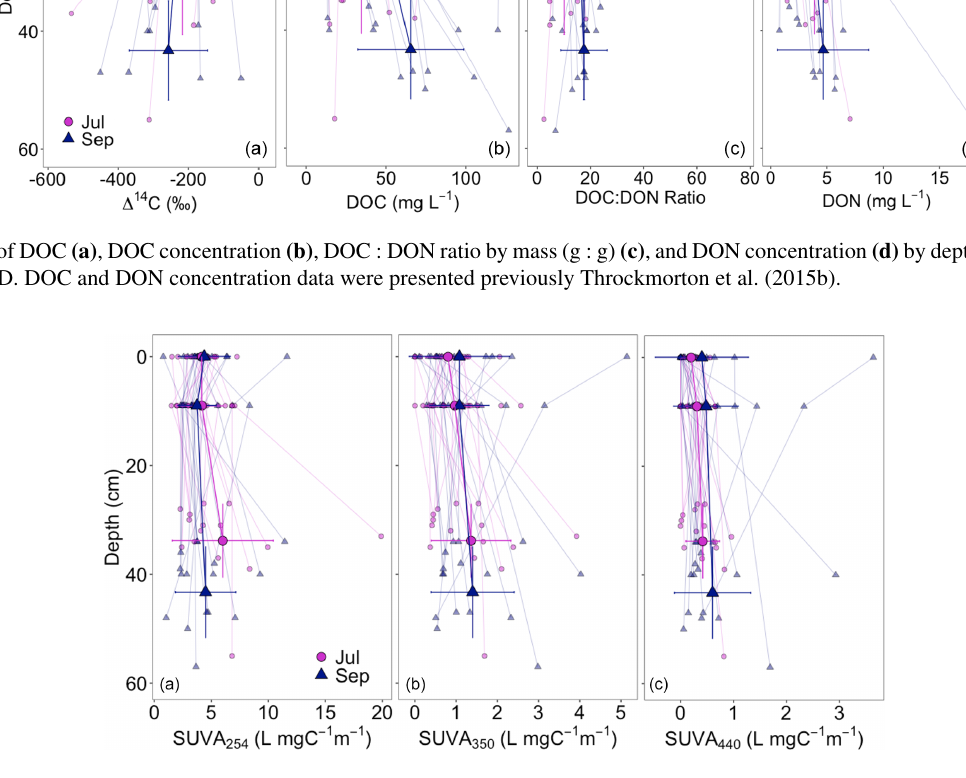
Figure 3. SUVA 254 (a) , SUVA 350 (b) , and SUVA 440 (c) by depth. Large symbols are means ±